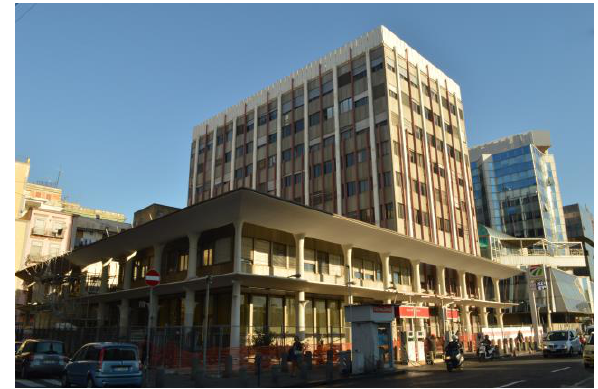
Figure 1. The office building of the University of Naples Federico